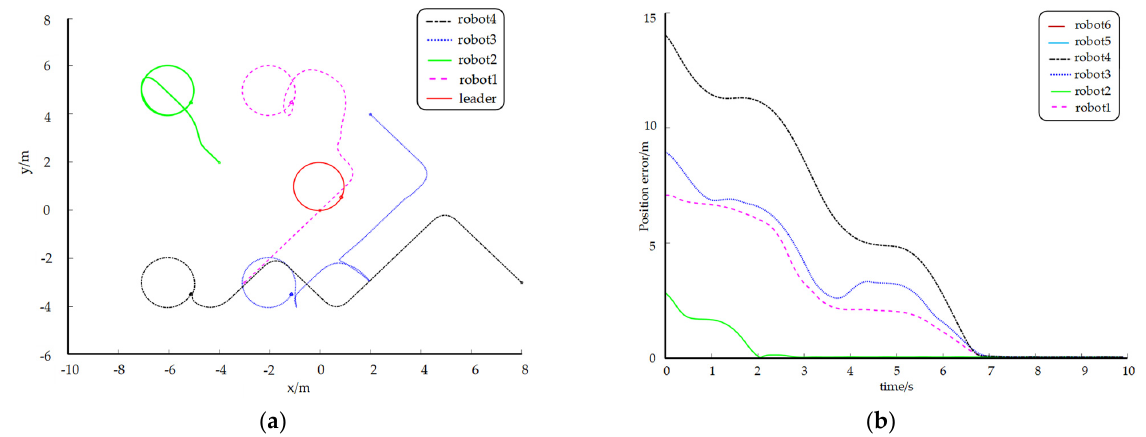
Figure 8. ( a ) Formation trajectory of each follower robot and leader robot; ( b ) Formation position error of each following robot and leader robot.